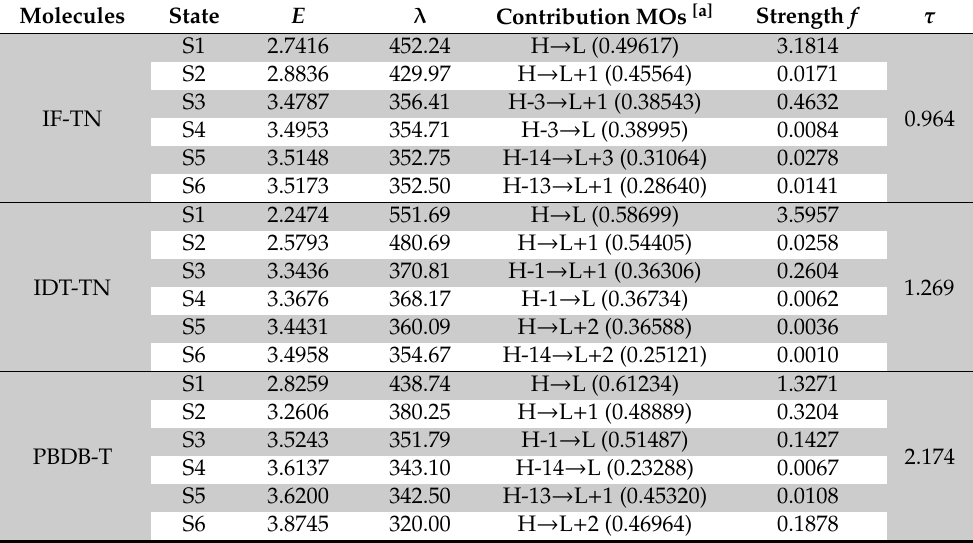
Table 3. Values for transition energy E (eV), absorption peak λ (nm), oscillator strength,